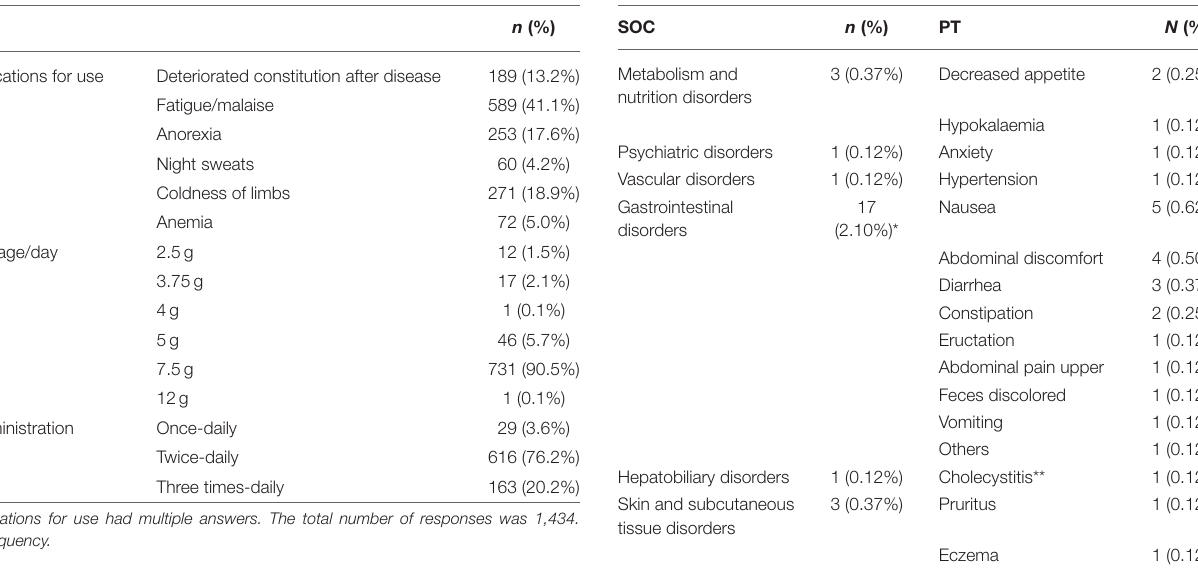
TABLE 4 | Drug usage.